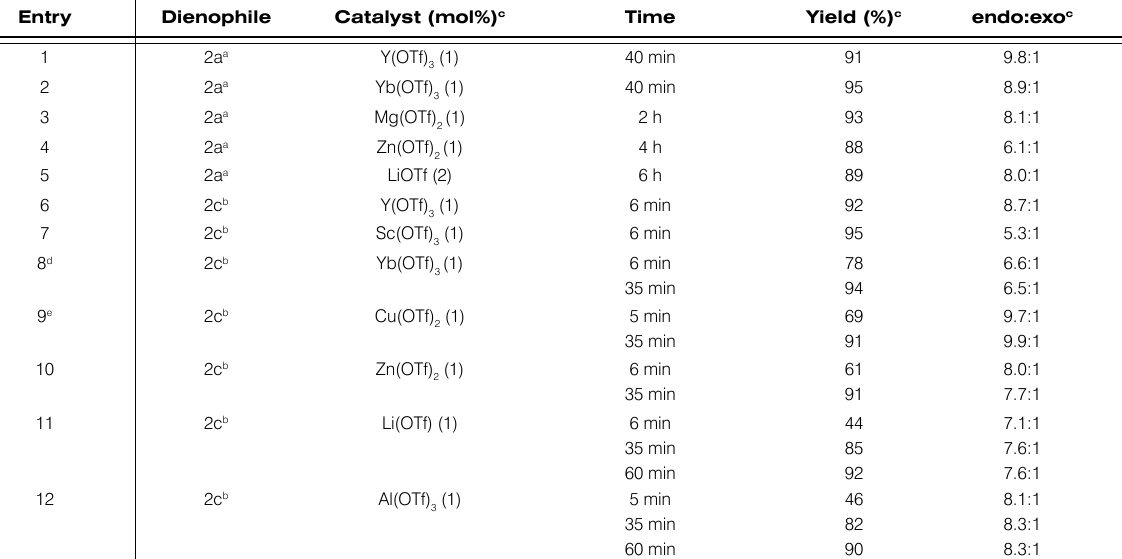
Table 3. Comparison of the catalytic activity of metal triflates in the Diels-Alder reaction between cyclopentadiene and 2a or 2c in deanol based ILs. Entry